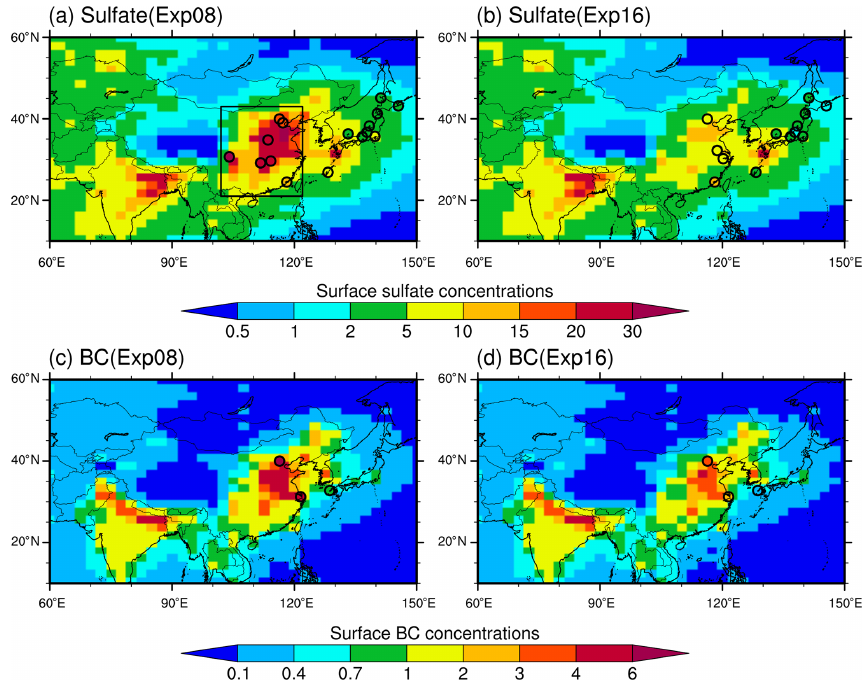
Figure 1. Map of simulated surface PM 2 . 5 sulfate (a–b) and BC (c–d) concentrations (units: µgm − 3 ) in China and surrounding areas in the Exp08 (emissions for the year 2008) and Exp16 (emissions for 2016) cases. Only the changes in anthropogenic emissions in China were considered in these simulations, and the temporal changes of aerosol concentrations may be biased in South Asia where observed aerosol burdens likely increased (Fig. S4). The observations of the annual mean sulfate and BC concentrations obtained from the EANET and literature (Table S1) are overlaid on the map of simulations for comparison. The geographical range of eastern China (21–43 ◦ N, 102– 122 ◦ E) is marked in panel (a) . The annual mean surface BC concentrations observed at Fukue island (32.75 ◦ N, 128.68 ◦ E) in western Japan for 2010 (c) and 2016 (d) are marked. PM 2 . 5 : particulate matter with aerodynamic diameter less than 2.5µm; BC: black carbon; EANET: Acid Deposition Monitoring Network in East